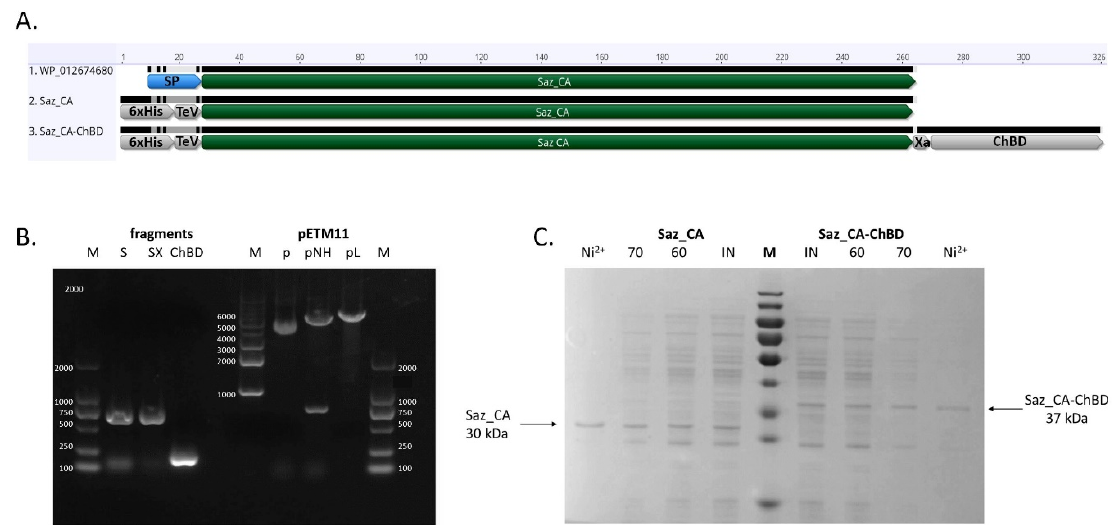
Figure 1. Construction and expression of Sulfurihydrogenibium azorense carbonic anhydrase (Saz_CA)